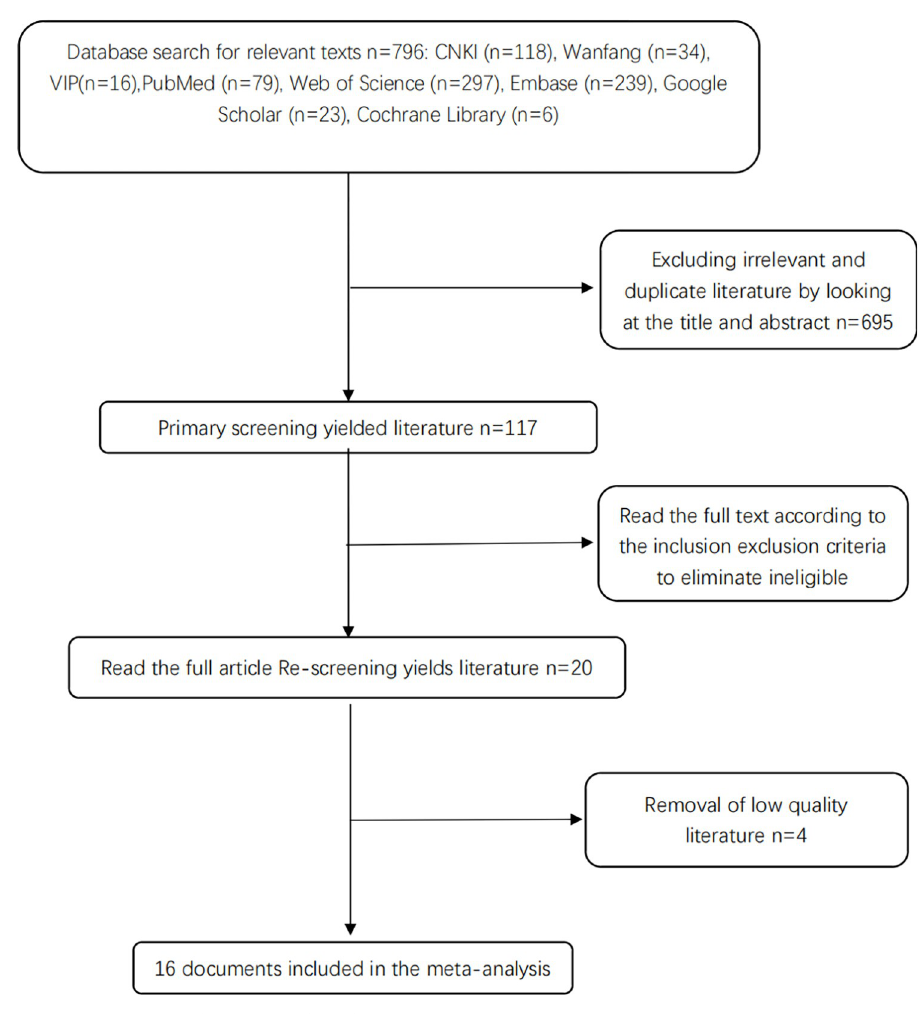
Fig 1. Literature search process and